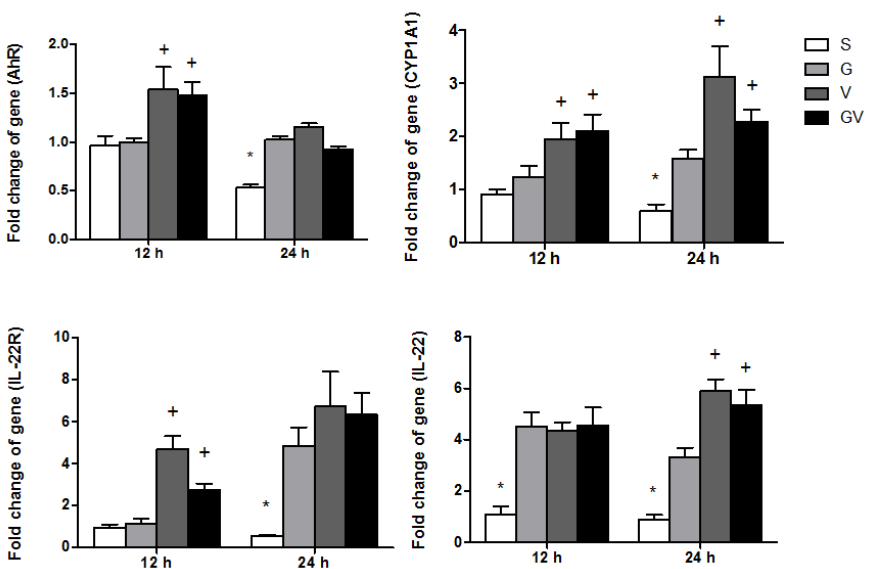
Figure 6. Aryl hydrocarbon receptor (AhR), cytochrome P450 1A1 (CYP1A1), interleukin (IL)-22, and IL-22 receptor (IL-22R) mRNA levels in ileum tissues after cecal ligation and puncture at two time points. mRNA changes were quantitated and analyzed by real-time PCR and were calculated by the comparative CT (2 − ∆∆ Ct ) method. mRNA expression levels in the S group were used as a calibrator. The groups are described in the legend of Figure 1. Data are shown as the mean ± SEM ( n = 8 for